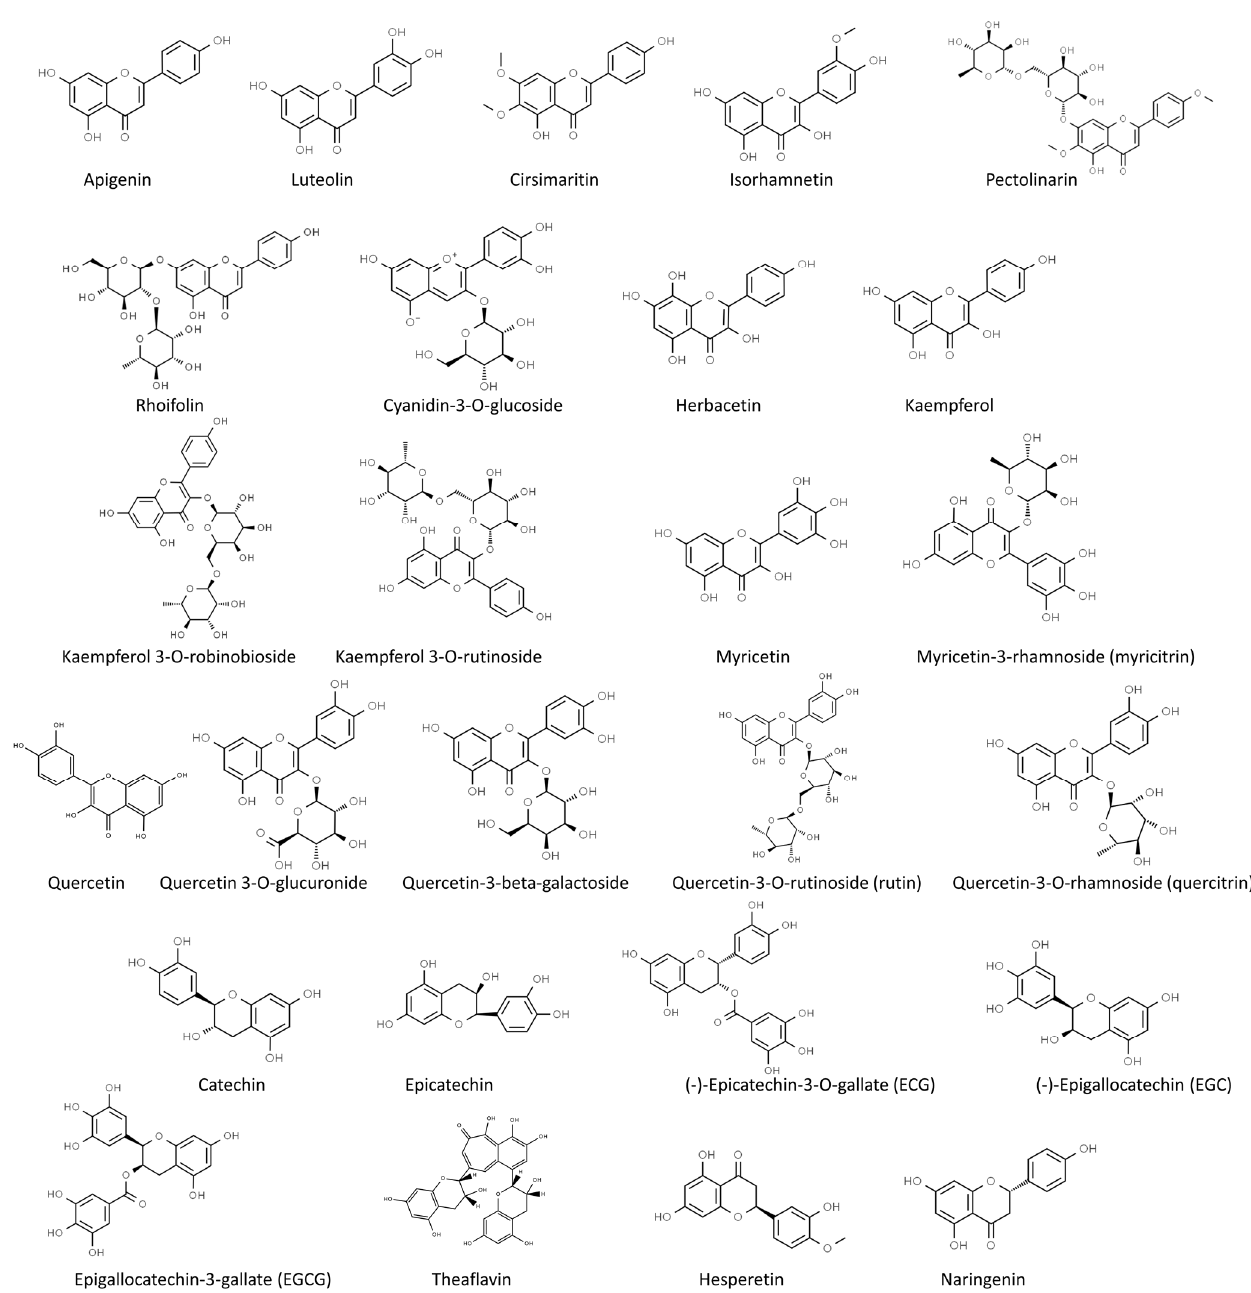
Figure 2. Chemical structure of the selected flavonoids (from ChemSpider, http://www.chemspider.com/ accessed on 24 February 2023).